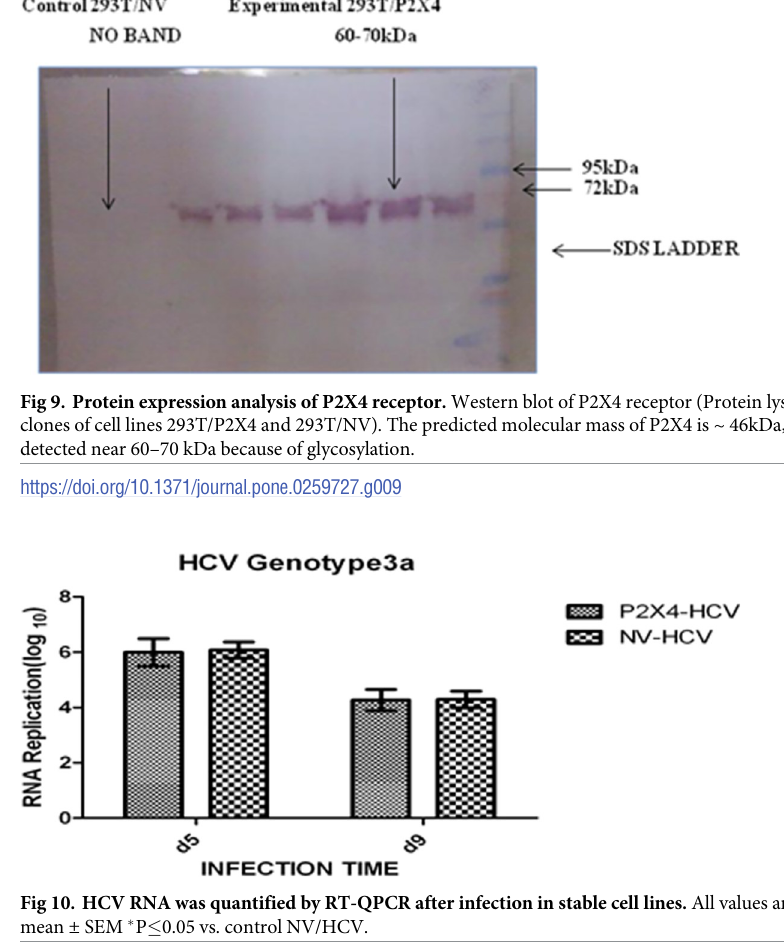
HCV disrupts the cellular balance of oxidant and antioxidants. Antioxidant effect was mea- sured in stably expressing cell line in the presence of HCV. Antioxidant heme oxygenase-1 (HO-1) is significantly up regulates in presence of P2X4 in HCV infected cells when compared